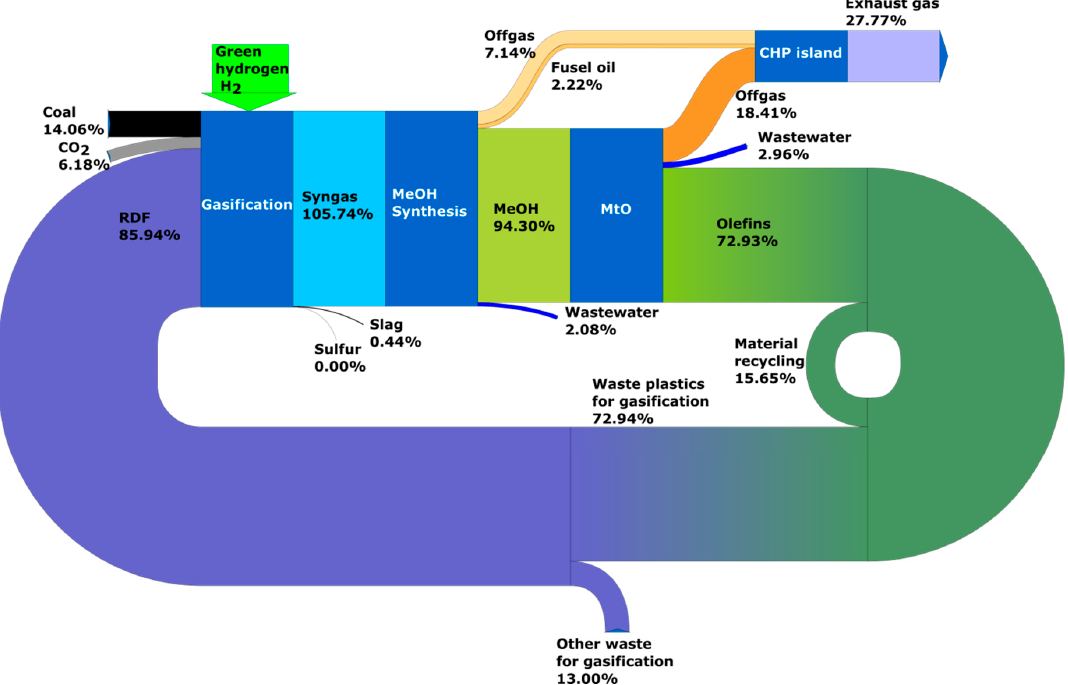
Figure 11. Carbon element distribution in olefins from hard coal and RDF production system with addition of ‘green hydrogen’ (2050).